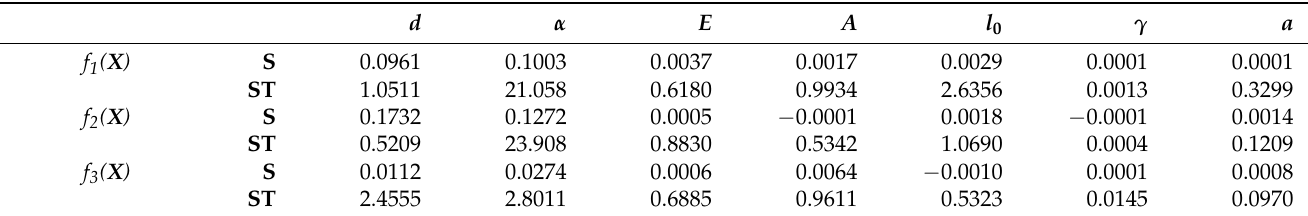
Table 2. First-order and total sensitive index of each parameter for different objective functions.